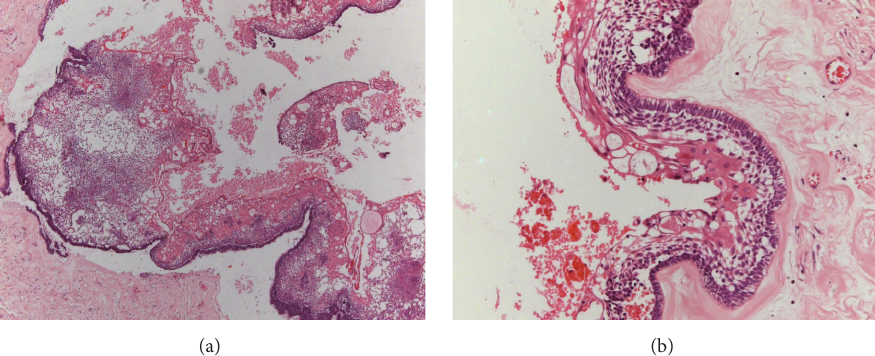
Figure 2: Microscopic characteristics. ((a) and (b)) A cystic cavity lined with epithelium was observed, in which the basal cells were columnar, hyperchromatic, and palisaded and had reversed polarity (Hematoxylin and Eosin: (a) 25x; (b)